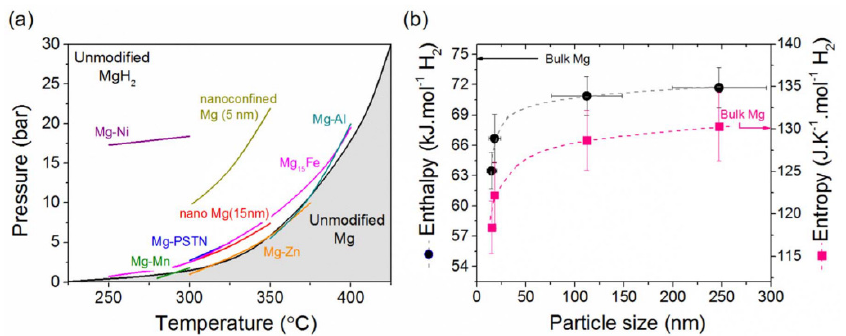
Figure 2. ( a )Temperature dependence of the dissociation pressure of MgH 2 and associated evolu- tion of such a dissociation pressure for various approaches investigated, and ( b ) evolution of Δ H and Δ S as a function of the particle size of Mg. (Reproduced with permission from ref. [47]. Copyright 2018 Elsevier.)